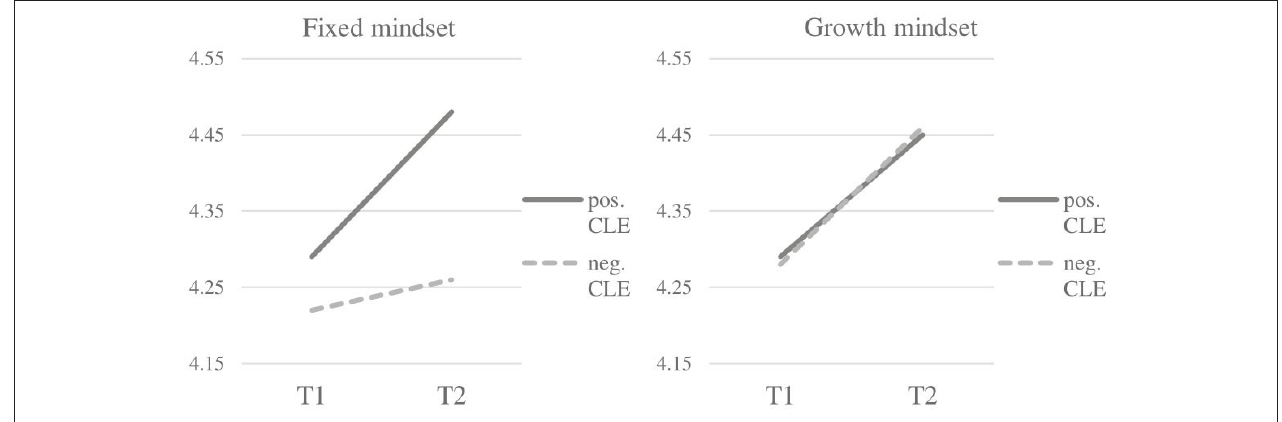
FIGURE 3 | Change in trait extraversion for people with a fixed vs. growth mindset with regard to the perception of life event graduation from school